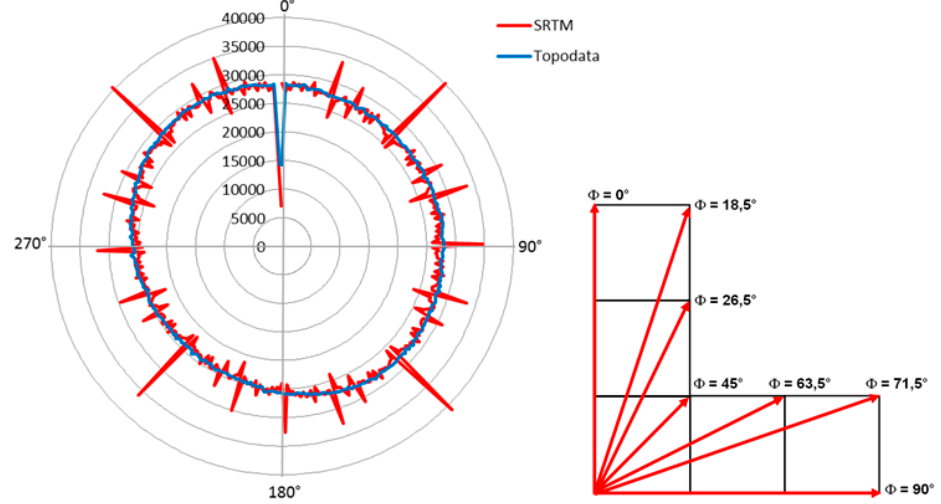
Figure 12. Aspect directional histograms in Topodata and SRTM and identification of main directions (source: [108]).